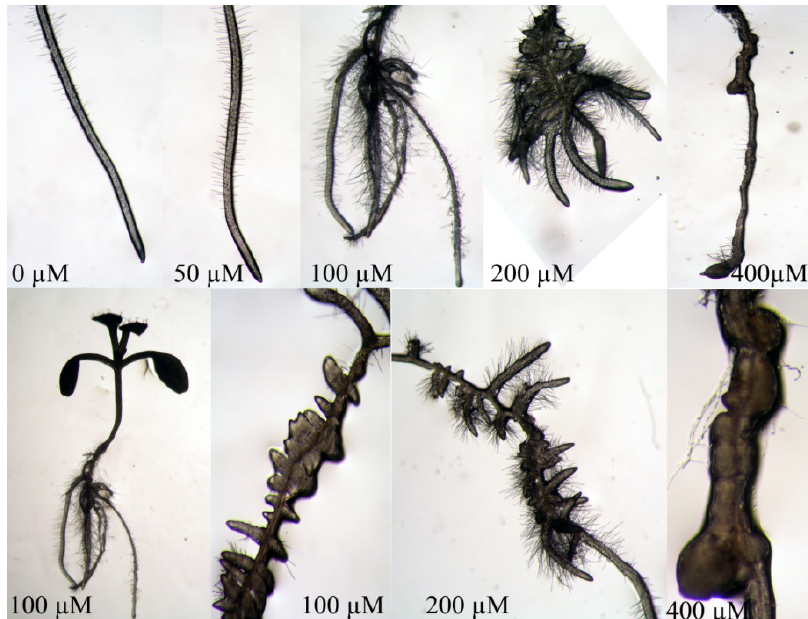
Figure 6. Root tip of A. thaliana grown in vitro and treated with different concentrations of compound 2 . Note the root malformation and the stimulation of lateral roots and root hairs. NB photos taken with different